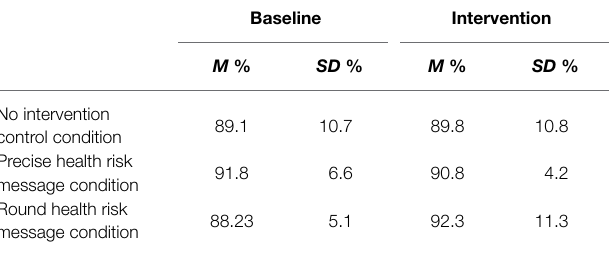
TABLE 1 | Mean stair use rates for intervention conditions. Baseline